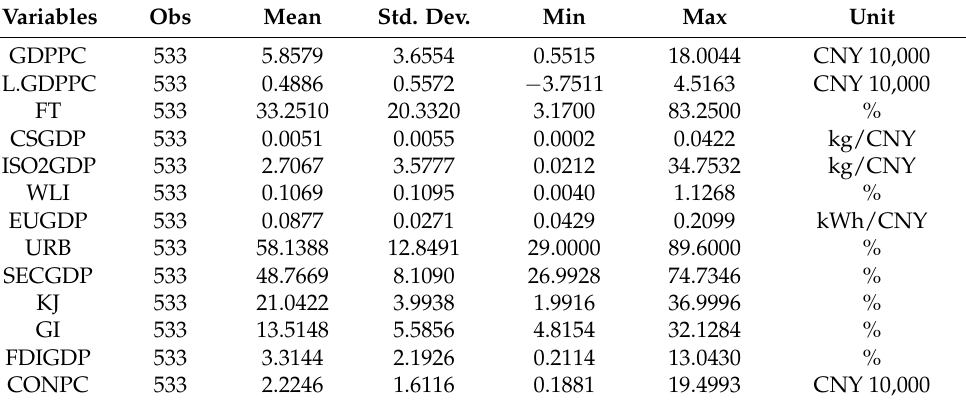
Table 3. Descriptive statistics of